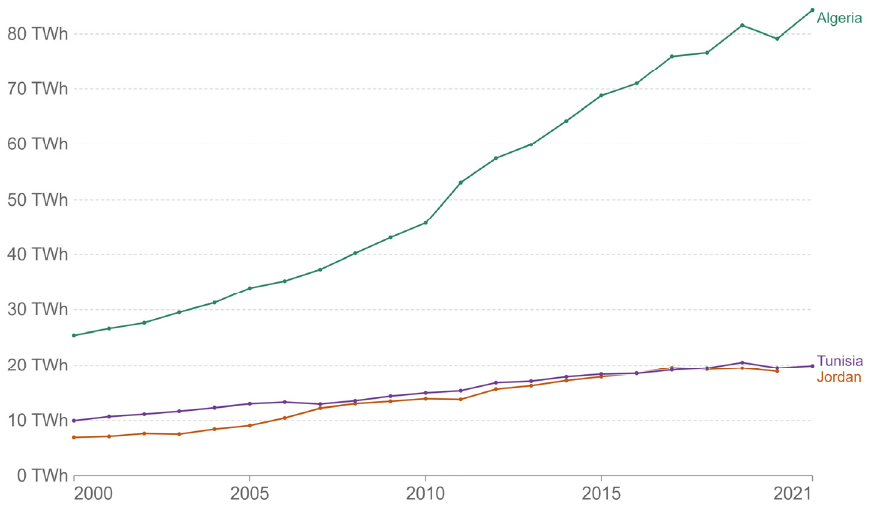
Figure 1. Electricity generation for Algeria, Tunisia and Jordan. Source: Our World in Data based on BP Statistical Review of World Energy (2022) and on Ember’s Global Electricity Review (2022). OurWorldInData.org/energy, CC BY.